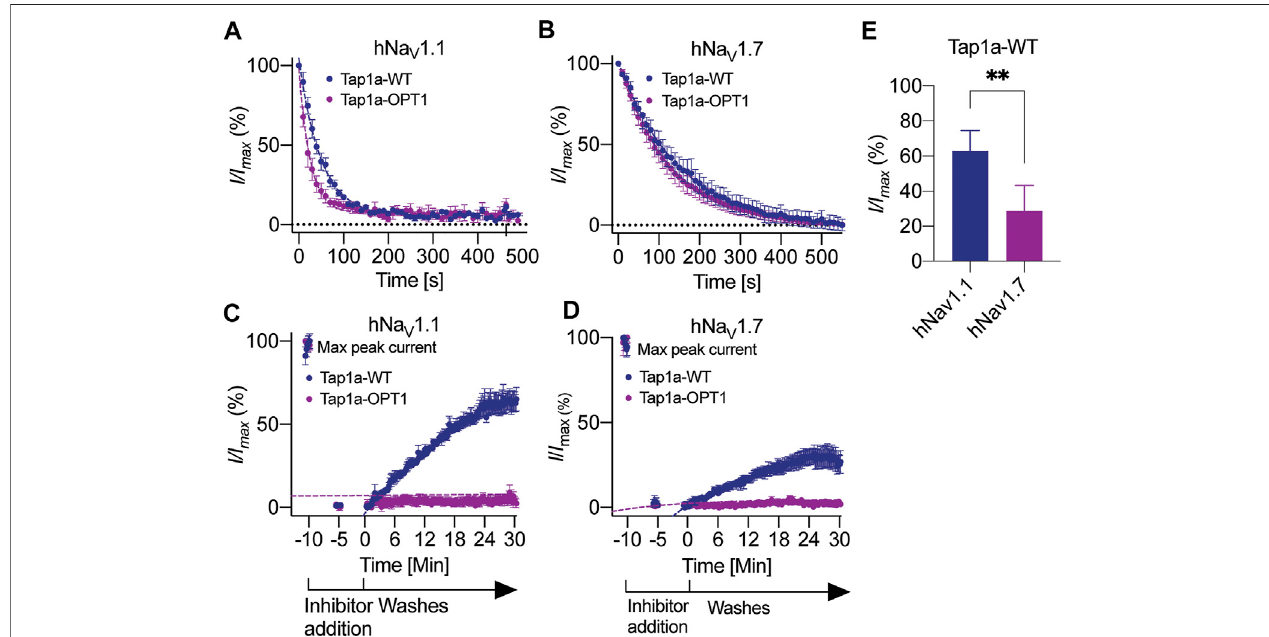
FIGURE 4 | Kinetics of Na V 1.1 and Na V 1.7 inhibition by Tap1a-WT and Tap1a-OPT1. (A, B) On-rate measurements for Tap1a-WT and Tap1a-OPT1 over Na V 1.1 (A) and Na V 1.7 (B) were calculated from fi tted exponentials of experiments recorded before and after addition of peptides at 10x IC 50 concentration. (C, D) Off- rate measurements of Tap1a-WT and Tap1a-OPT1 over Na V 1.1 and Na V 1.7 were calculated from the fi tted exponentials of experiments recorded before and after addition ofpeptidesat10xIC 50 concentrationfollowedbywasheswithextracellularsolution. (E) Na V currentsmeasuredattheendof30 minforNa V 1.land25 min for Na V 1.7 ligand wash-out period. ** p (cid:1) 0.0042. Statistical signi fi cance was determined by t -student test. All data points are mean ± SEM of 4 – 7 independent